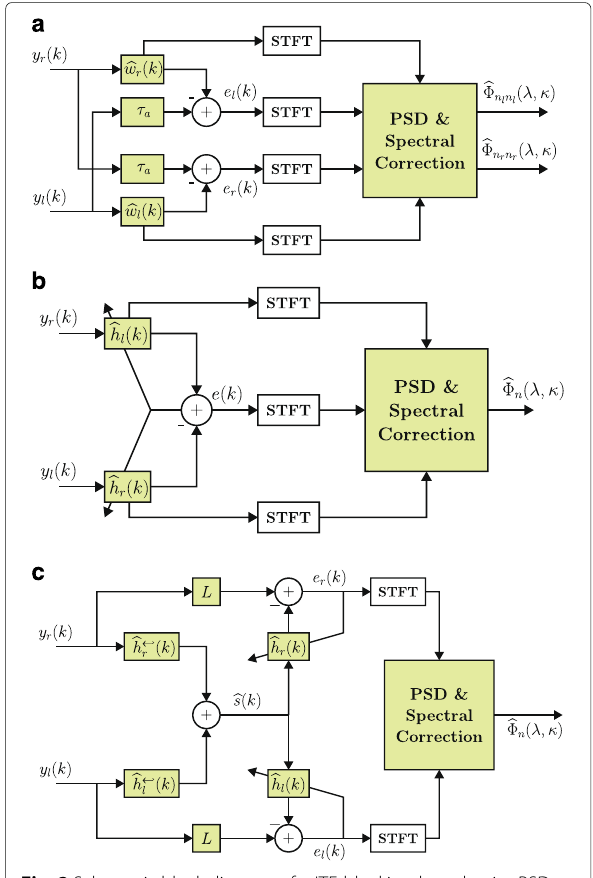
Fig. 2 Schematic block diagram of a ITF-blocking-based noise PSD estimation, b CR-blocking-based noise PSD estimation,